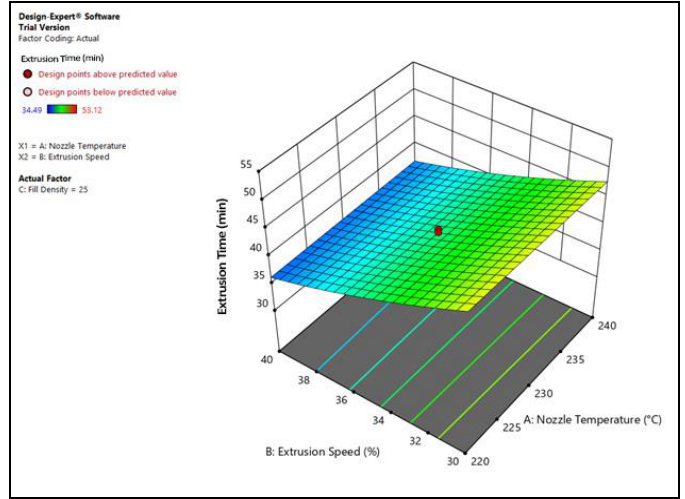
Fig. 10. Interaction effect analysis of factor A and B for the extrusion time.